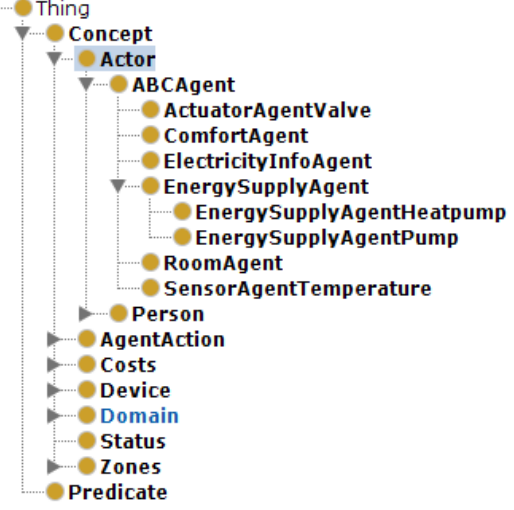
Figure 1. Main classes of the ontology, with detail on the agent